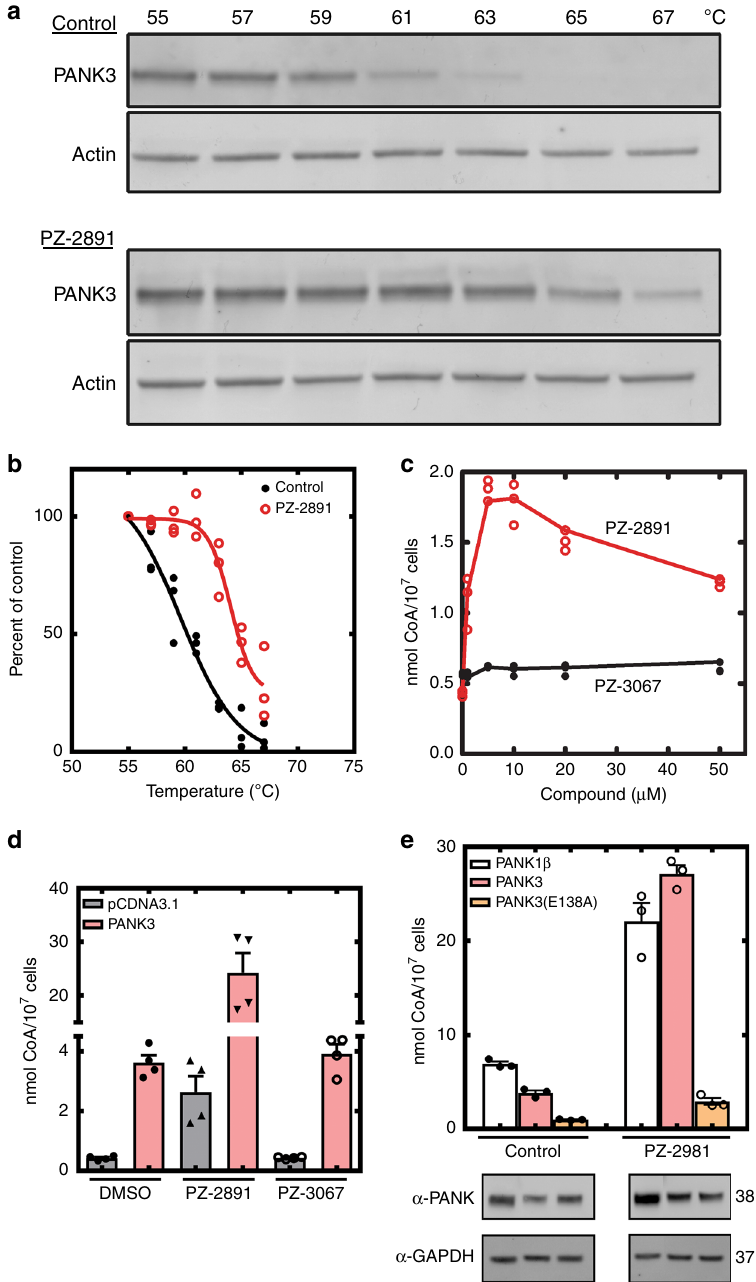
Fig. 4 Pantazine modulation of intracellular CoA levels. a Representative immunoblots from a cellular thermal shift (CETSA) assay showing the stabilization of PANK3 by PZ-2891. b PANK3 stability in the presence (red open circles) and absence ( fi lled black circles) of 10 μ M PZ-2891. These data were obtained from three independent biological experiments. c Intracellular CoA levels in C3A cells. Cell cultures were treated with either 10 μ M PZ-2891 (red open circles) or its inactive homolog, PZ-3067 ( fi lled black circles), and the CoA levels were determined. These data were derived from three independent biological experiments. d HEK293T cells were transfected with either an empty vector (gray bars) or vector driving the expression of PANK3 (pink bars), and the cells were treated with either 10 μ M PZ-2891 or PZ-3067. The data are from two independent biological experiments performed in duplicate and the mean ± SEM is plotted. e HEK293T cells were transfected with expression vectors for either PANK1 β (white bars), PANK3 (pink bars), or PANK3 (E138A) (orange bars) . PANK3(E138A) is a catalytically inactive mutant. Triplicate dishes of cells were treated for 24 h with either DMSO or 10 μ M PZ- 2891 in DMSO, the cells were harvested and the total intracellular CoA levels determined. Data were plotted as the mean ± SEM. Isoform expression was veri fi ed by immunoblotting cells samples with an anti-PANK antibody ( α -PANK) raised against the catalytic core common to all